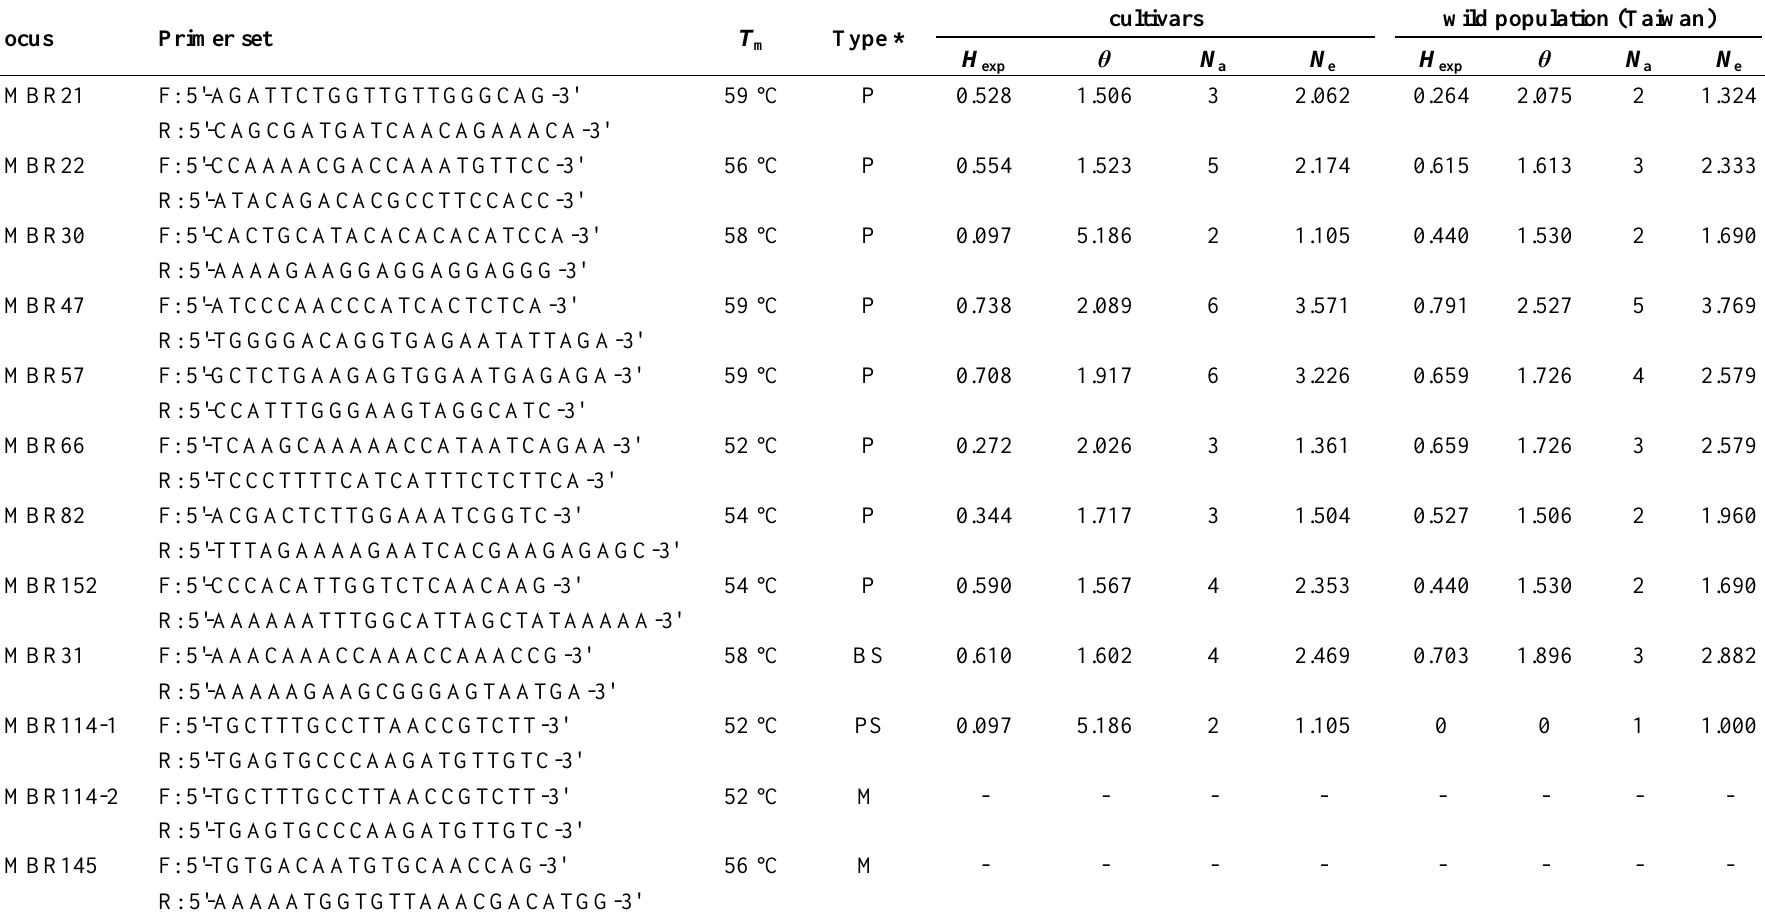
Table 2. Primer sequences, annealing temperature ( T ( H ), genetic diversity index ( θ ), number of alleles and effective alleles ( N exp forward and reverse primers are denoted in “F” and “R” in front of the primer sequences, respectively.